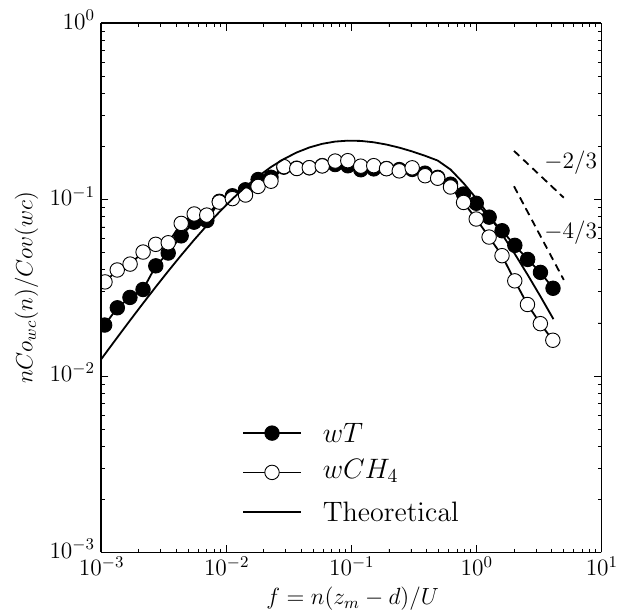
Figure 3. Frequency-binned and averaged co-spectra of sensible heat and methane fluxes for periods with unstable regime ( − 650 < L < 0). The − 4 / 3 and − 2 / 3 power laws are shown with dashed lines.